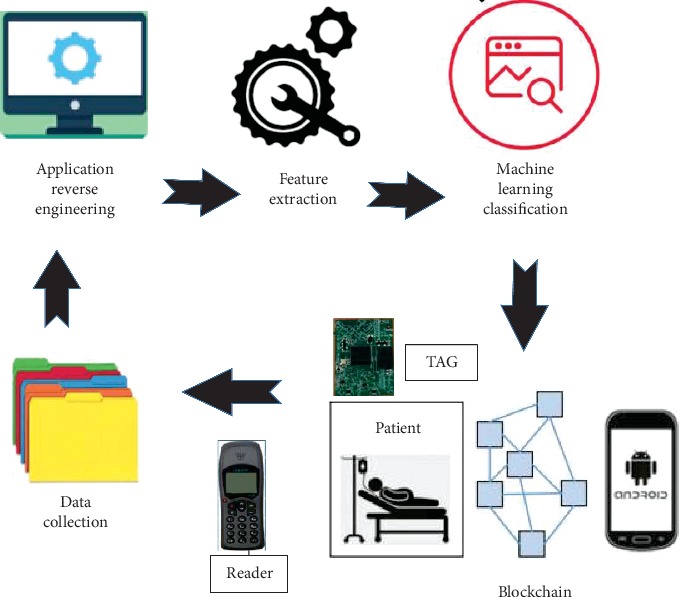
The medical framework based on RFID, blockchain, and artificial intelligence.